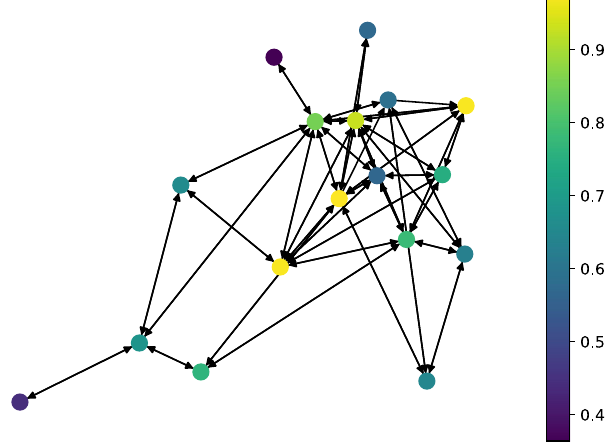
FIG. 3. Collaboration network from the Fall 2020 course at Mines. This network does not show six disconnected nodes representing students for whom no collaborations were reported. Nodes are colored based on the outward directed closeness centrality c Co .